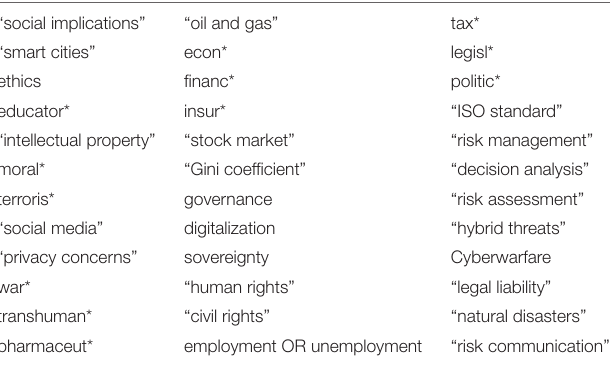
TABLE 1 | Keywords in the Social Domain (quotes indicate keywords formed by multiples words. The asterisk denotes wildcard searches.). “social implications”